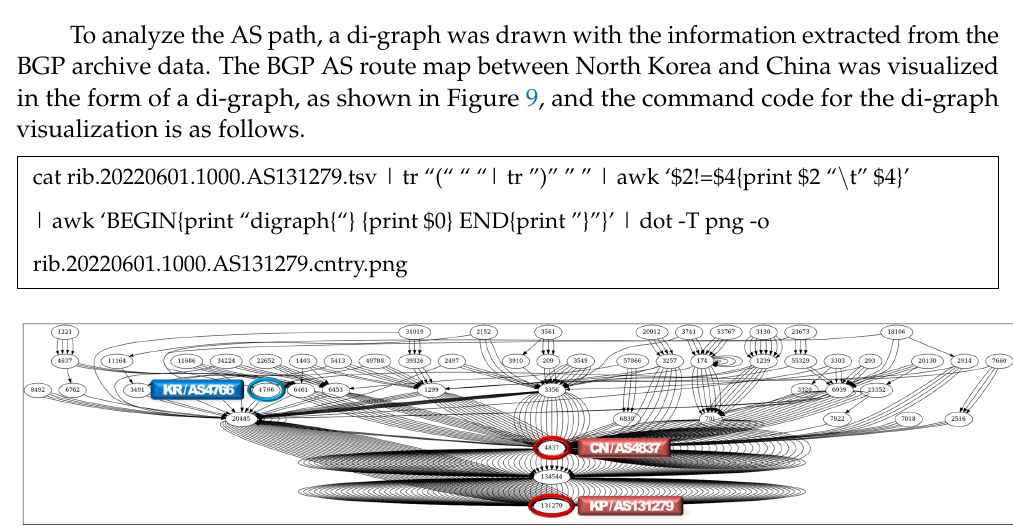
Figure 8. Design of DB for collection and pre-processing data relation.